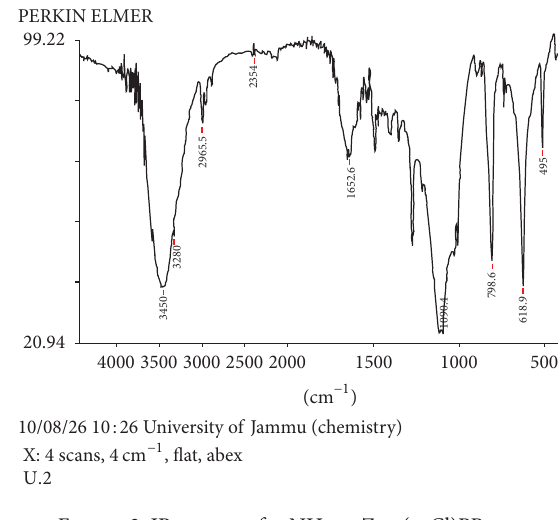
py-Zn-t(p-Cl)PP. 2